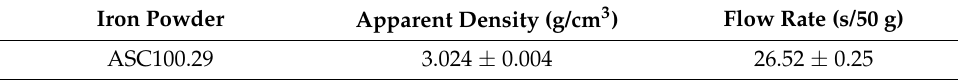
Figure 3. Micrographs of iron powder ASC100.29. ( A ) Magnification 800× and ( B ) Magnification 1500×. Table 1. Apparent density and flow rate of iron powder ASC100.29.